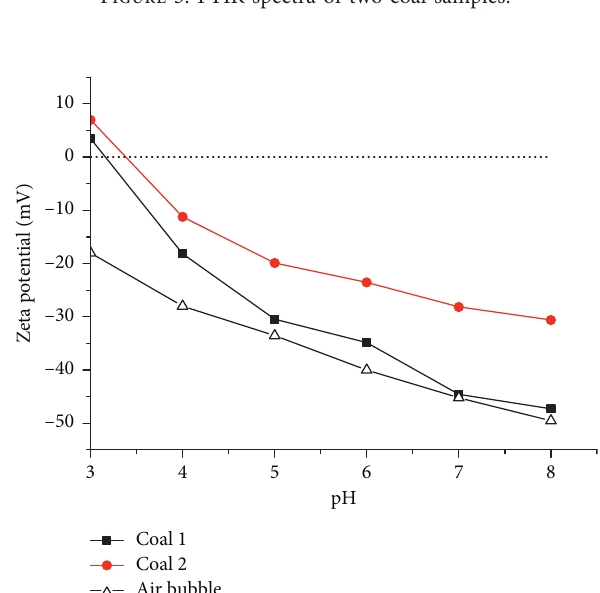
Figure 4: Zeta potential measurements versus pH solutions for two coal samples and air